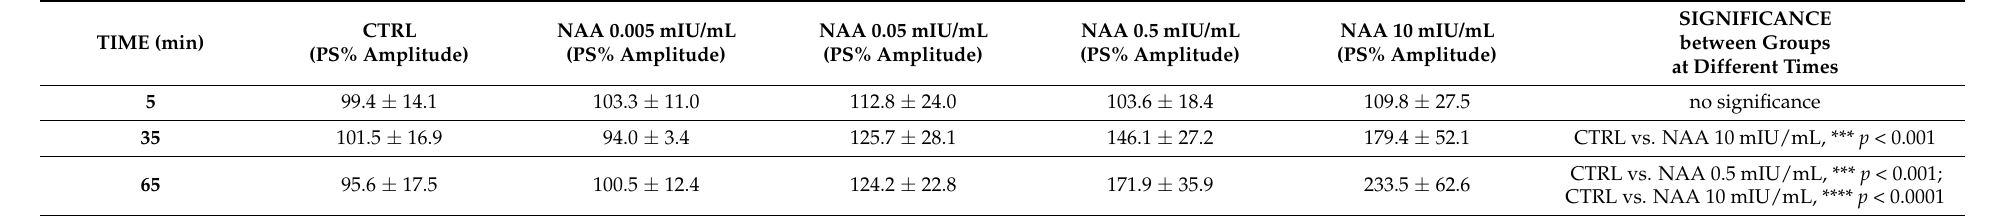
Table 1. Percentage of PS amplitude values of BST recorded in the CA1 region of hippocampal slices from the control group and groups treated with different concentrations of NAA at different